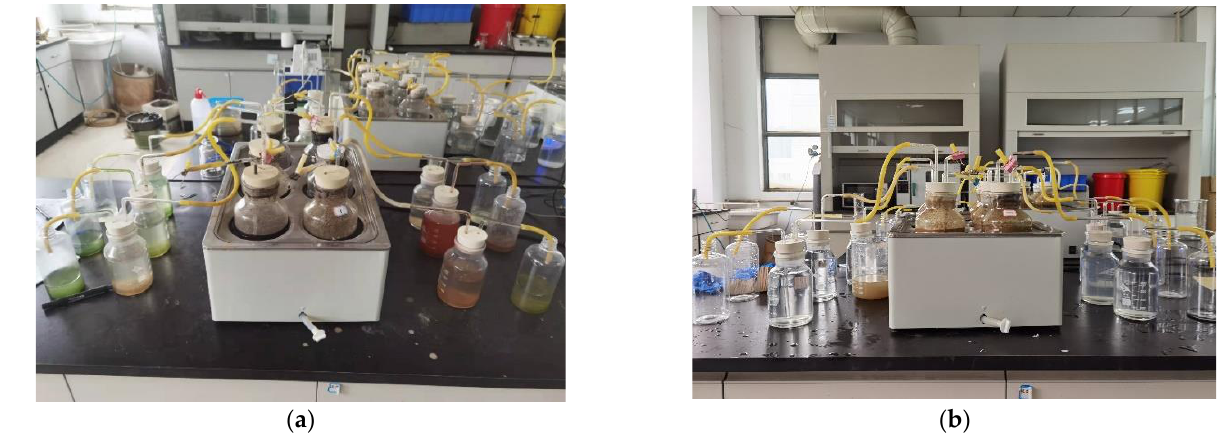
Figure 1. The top ( a ) and front ( b ) of self-made laboratory anaerobic digestion device. Table 2. Experimental designs.